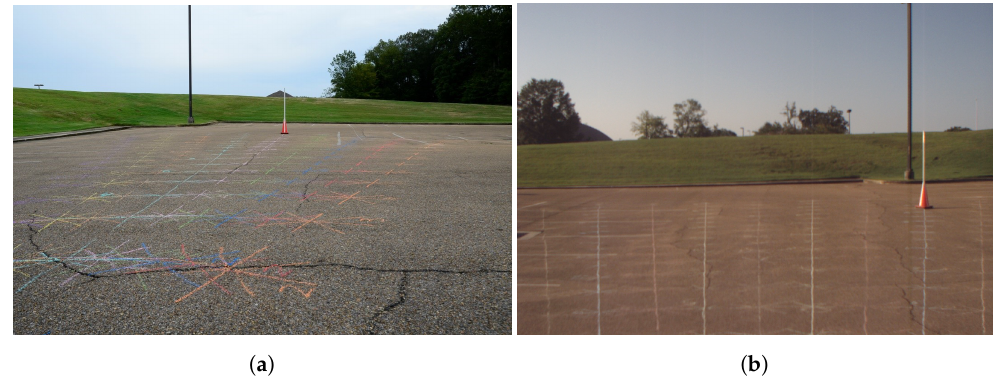
Figure 7. ( a ) Markings on the ground. ( b ) View from the camera. Markings on the ground covering the full FOV and detection range of the